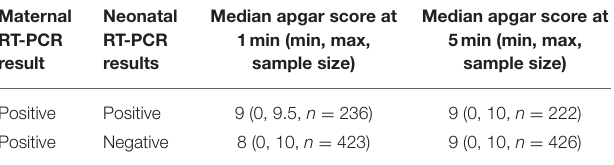
TABLE 1 | Median apgar scores according to RT-PCR test.